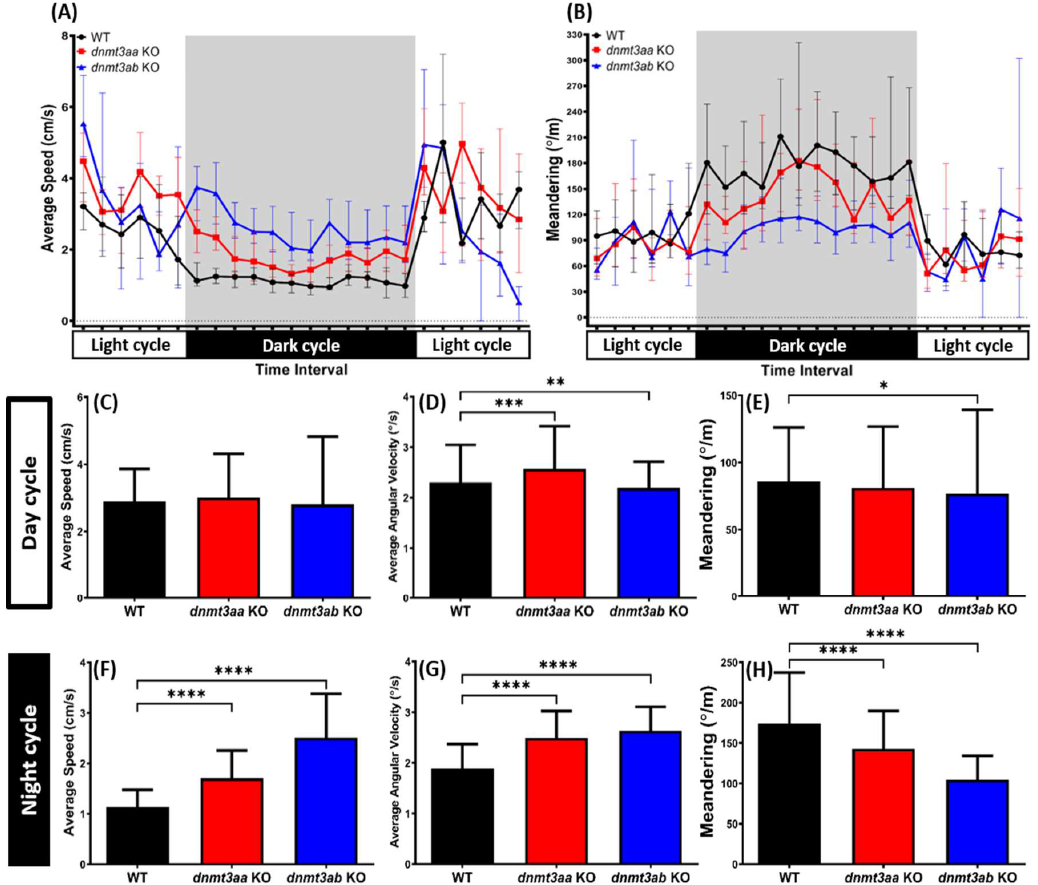
Figure 8. The circadian rhythm locomotor activity for wild-type, dnmt3aa , and dnmt3ab mutant fish. ( A , B ) Comparison of the average speed and meandering, respectively, between wild-type, dnmt3aa , and dnmt3ab KO fish during the light and dark cycles. Comparisons of the average speed ( C , F ), average angular velocity ( D , G ), and meandering ( E , H ) in light and dark cycles, respectively, were demonstrated. Data are presented as median with interquartile range and analyzed by Mann–Whitney test ( n = 28 for wild type; n = 18 for dnmt3aa KO fish; n = 18 for dnmt3ab KO fish; * p < 0.05, ** p < 0.01, *** p < 0.005, **** p < 0.0001).